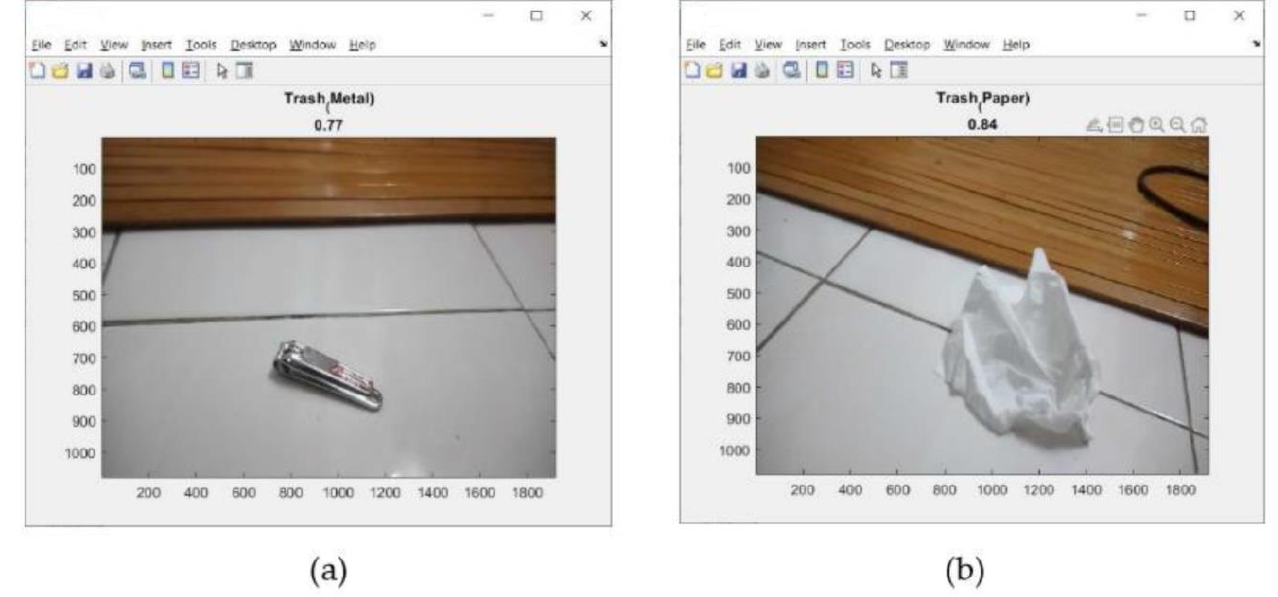
Figure 19. Results of trash identification using a real-time camera. ( a ) Cardboard; ( b ) food packag- ing.